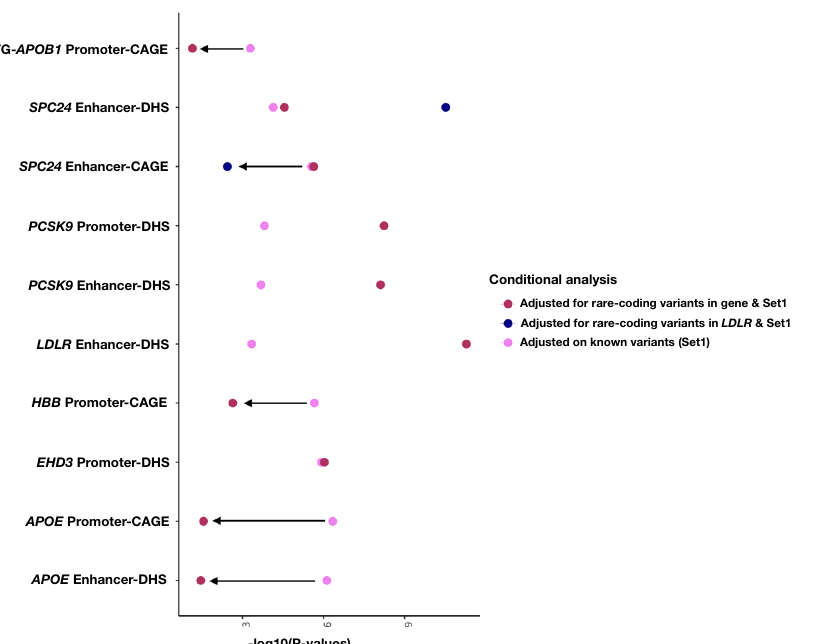
Fig. 4 | Conditional analysis of coding rare-variants from the same gene and a near-bygene. Non-codingrarevariantsetssigni fi cantlyassociatedwithTCandTG after the conditional analysis on known variants are shown with additional adjustment on rare-coding variants. The additional adjustment for rare-coding variants were carried out for the same gene of the aggregate set and for certain gene aggregates (SPC 24 ) the conditional analysis was carried out with a nearby Mendeliangene.Afteradjusting forrare-codingvariantsandknownvariants, EHD3 signal drops minimally, whereas signal from PCSK9 (promoter-DHS, enhancer- DHS), LDLR -loci (enhancer-DHS, SPC 24 enhancer-DHS) enhances signi fi cantly.